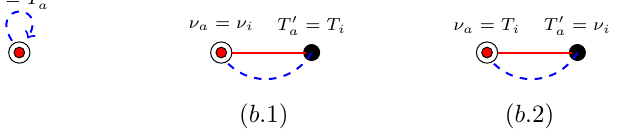
= T 0 , ( b ) Parallel Edges: ( b. 1) ν 0 a a